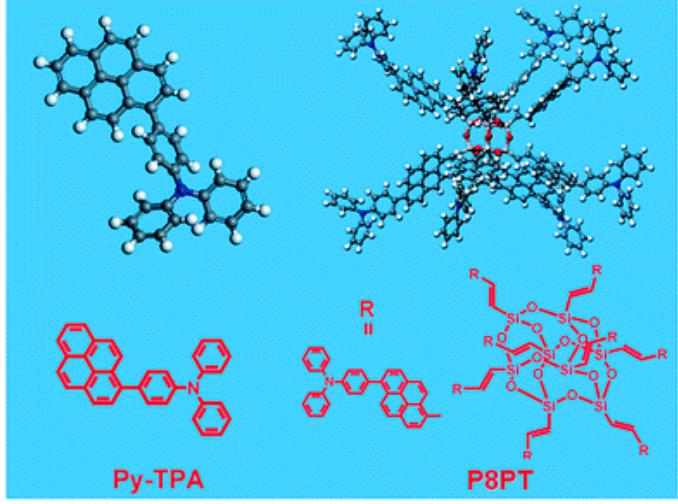
Figure 12. Structures of Py-TPA and P8PT [42] . Copyright 2015, Royal Society of Chemistry.